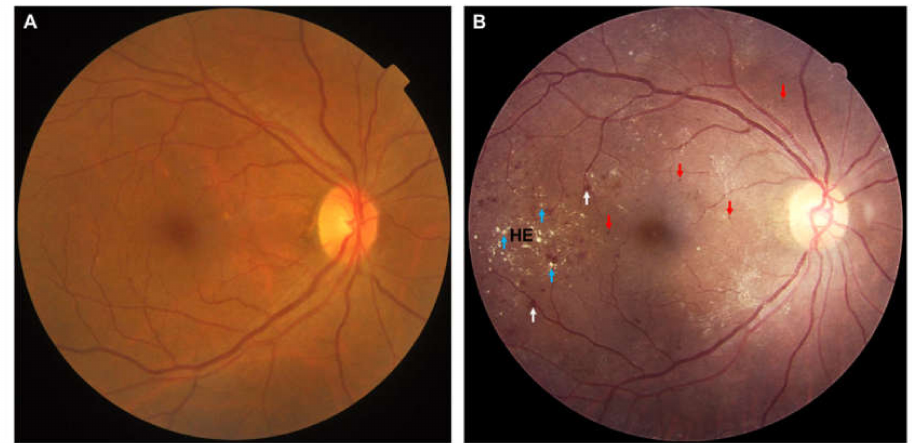
Figure 1. ( A ) Color fundus photograph of the right eye of a 58-year-old woman, without any chronic systemic diseases or eye diseases. ( B ) Color fundus photograph of the right eye of a 45-year-old man with signs of moderate non-proliferative diabetic retinopathy. Notably, features include microaneurysms (red arrows), dot- and blot- hemorrhages (white arrows) and hard exudates (HE, blue